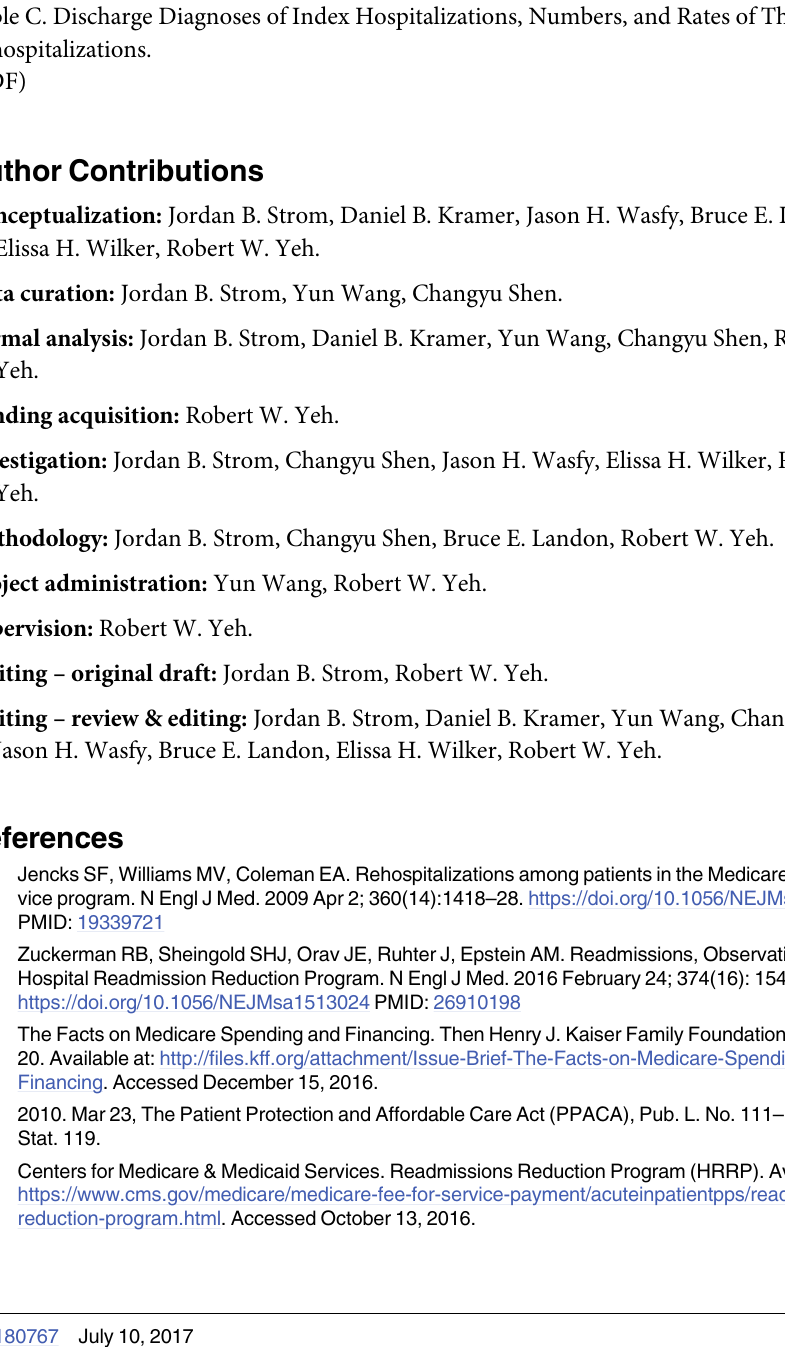
S1 File. Table A. Comorbid Conditions Included in the Agency for Healthcare Research and Quality Risk Adjustment Model. Table B. Most Common Discharge Diagnoses Leading to Readmission Overall. Table C. Discharge Diagnoses of Index Hospitalizations, Numbers, and Rates of Thirty Day